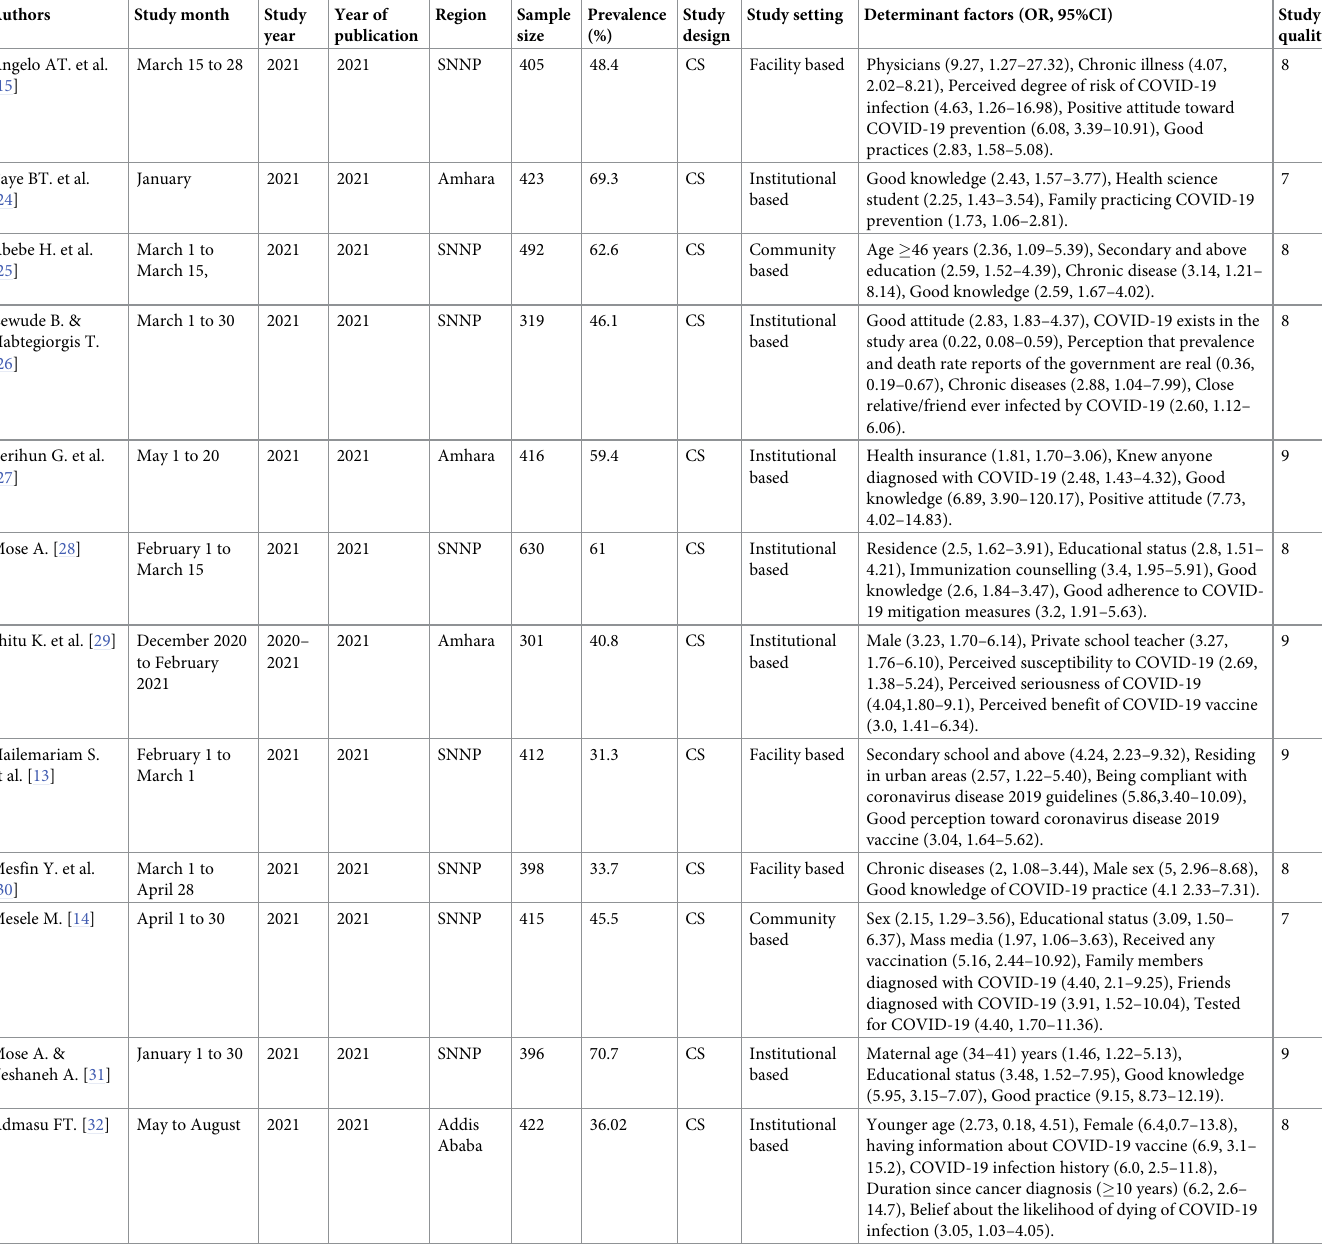
Table 1. Study characteristics included in the systematic review and meta-analysis on the prevalence of COVID-19 vaccine acceptance and its determinants in